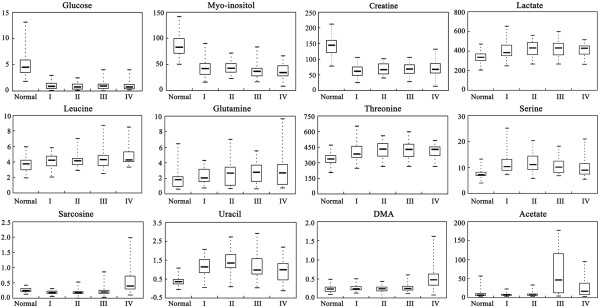
Box-and-whisker plots illustrating discrimination between different stages of rectal cancers and normal controls. Horizontal line in the middle portion of the box, median; bottom and top boundaries of boxes, 25th and 75th percentiles, respectively; lower and upper whiskers, 5th and 95th percentiles, respectively.